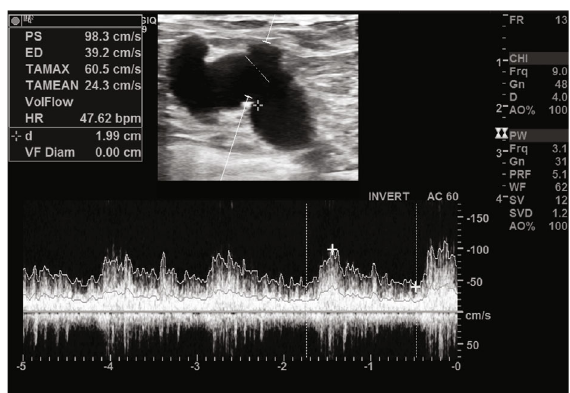
Figure 1: Duplex ultrasound showing an abnormally shaped AV fi stula with associated pseudoaneurysm.